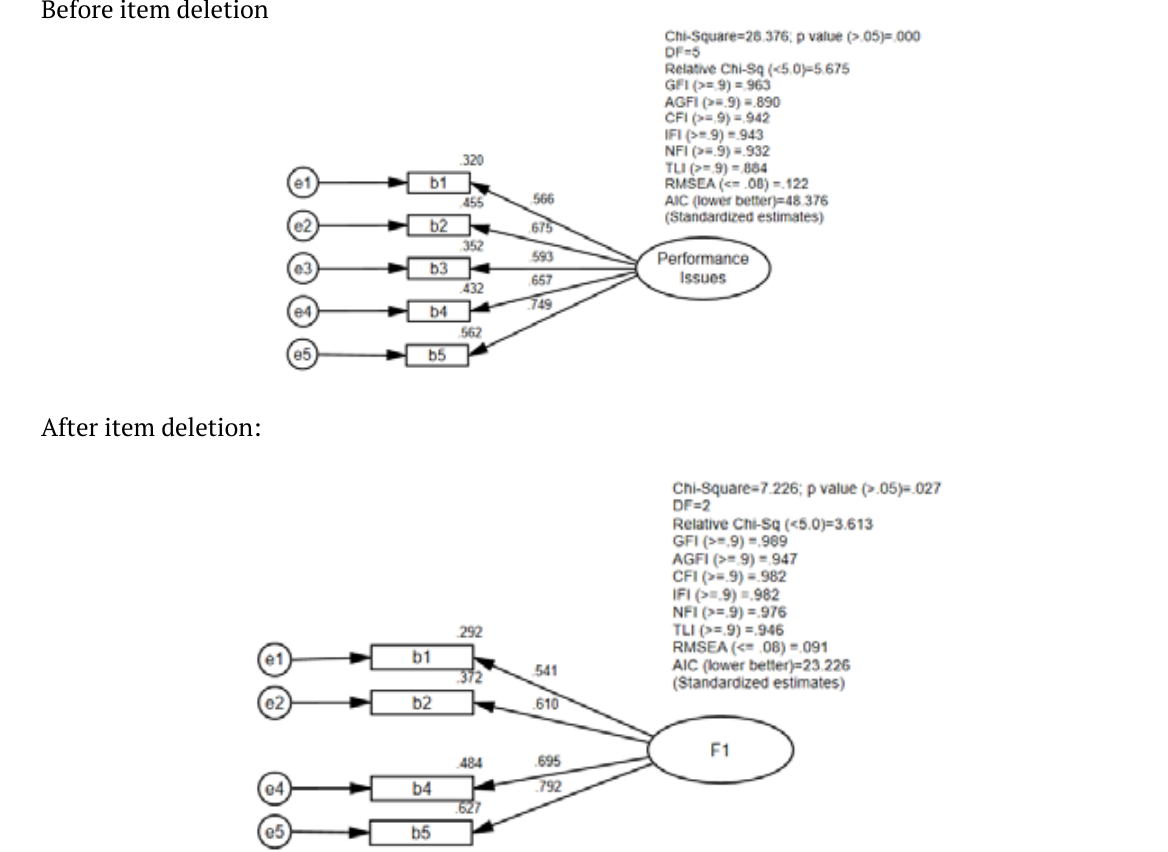
Figure 1. Confirmatory Factor Analysis for Performance